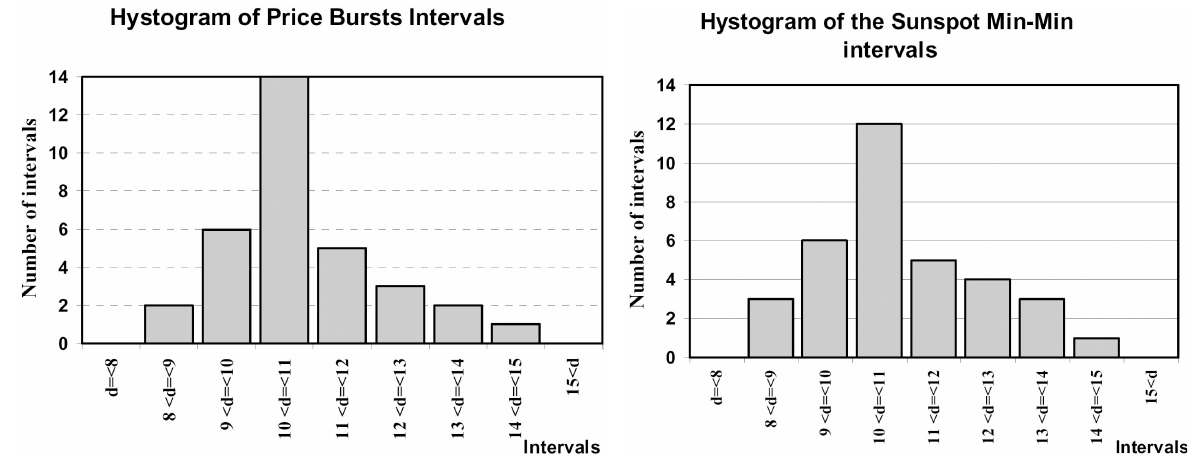
Fig. 6. Distributions of intervals d (in years) between wheat price bursts during 1249–1702 (left), and of intervals between minimums of sunspot numbers during 1700–2000 (right). According to Pustil’nik et al. (2003).